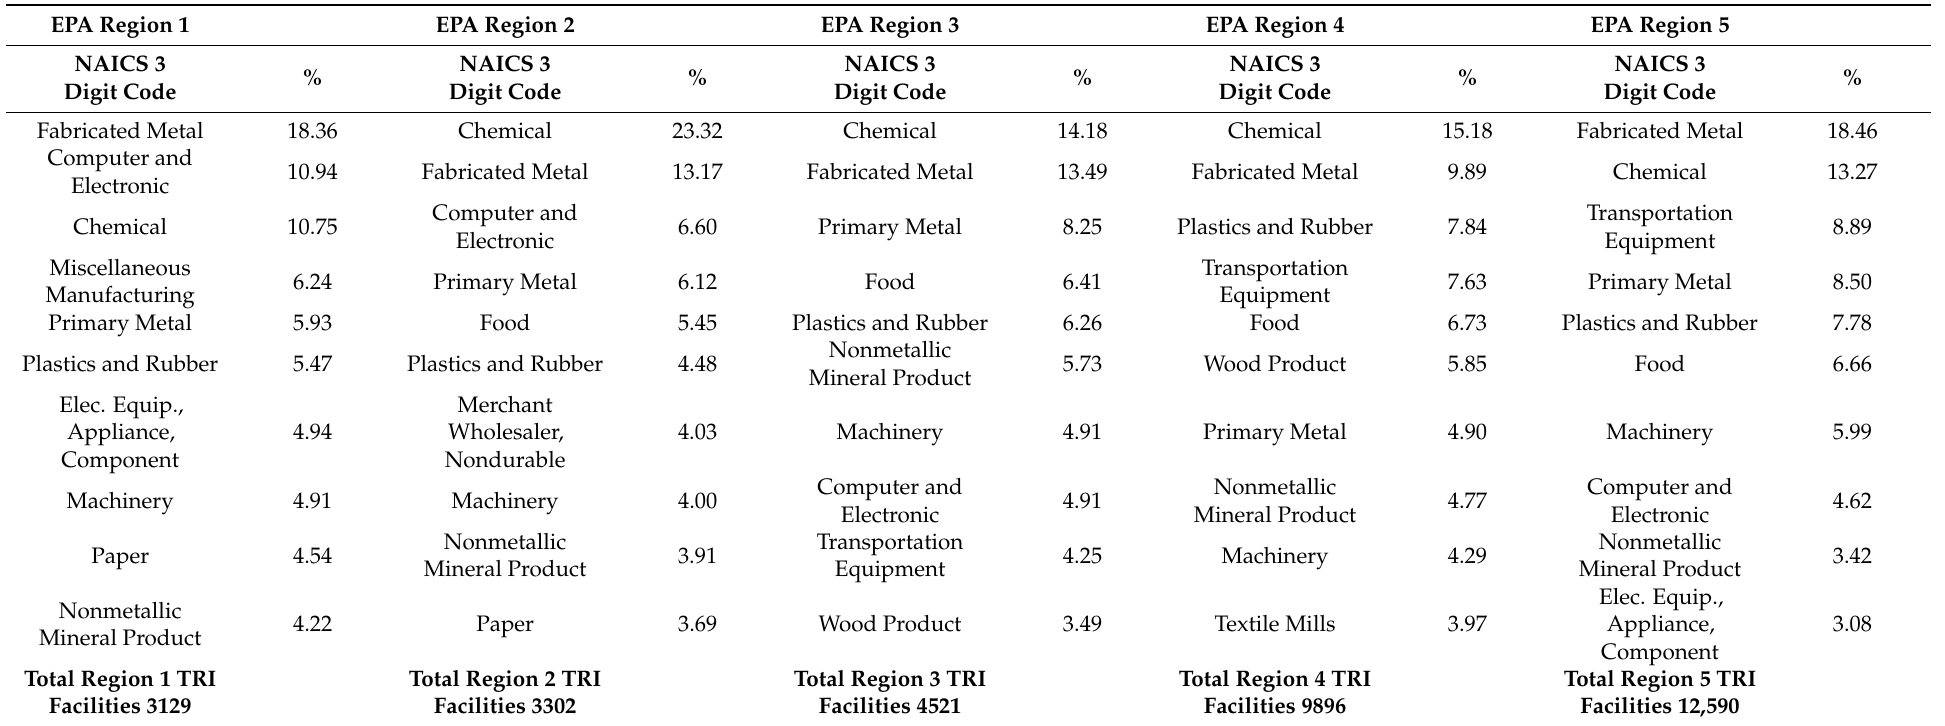
Table 1. Location of USEPA regulated facilities organized by their primary three-digit North American industry classification system for each of the ten US EPA regions. EPA Region